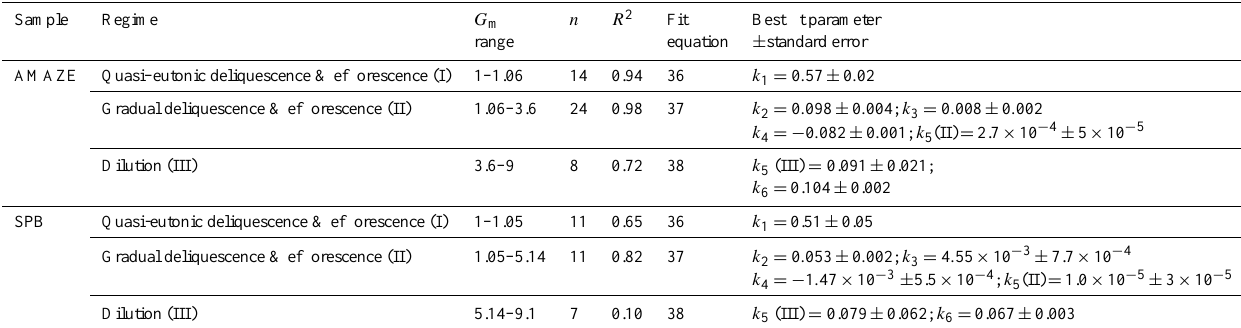
Table 5. KIM fit parameters for the atmospheric aerosol samples collected in the Amazon (AMAZE) and in St. Petersburg (SPB). n and R 2 are the number of data points and the coefficient of determination of the fit.